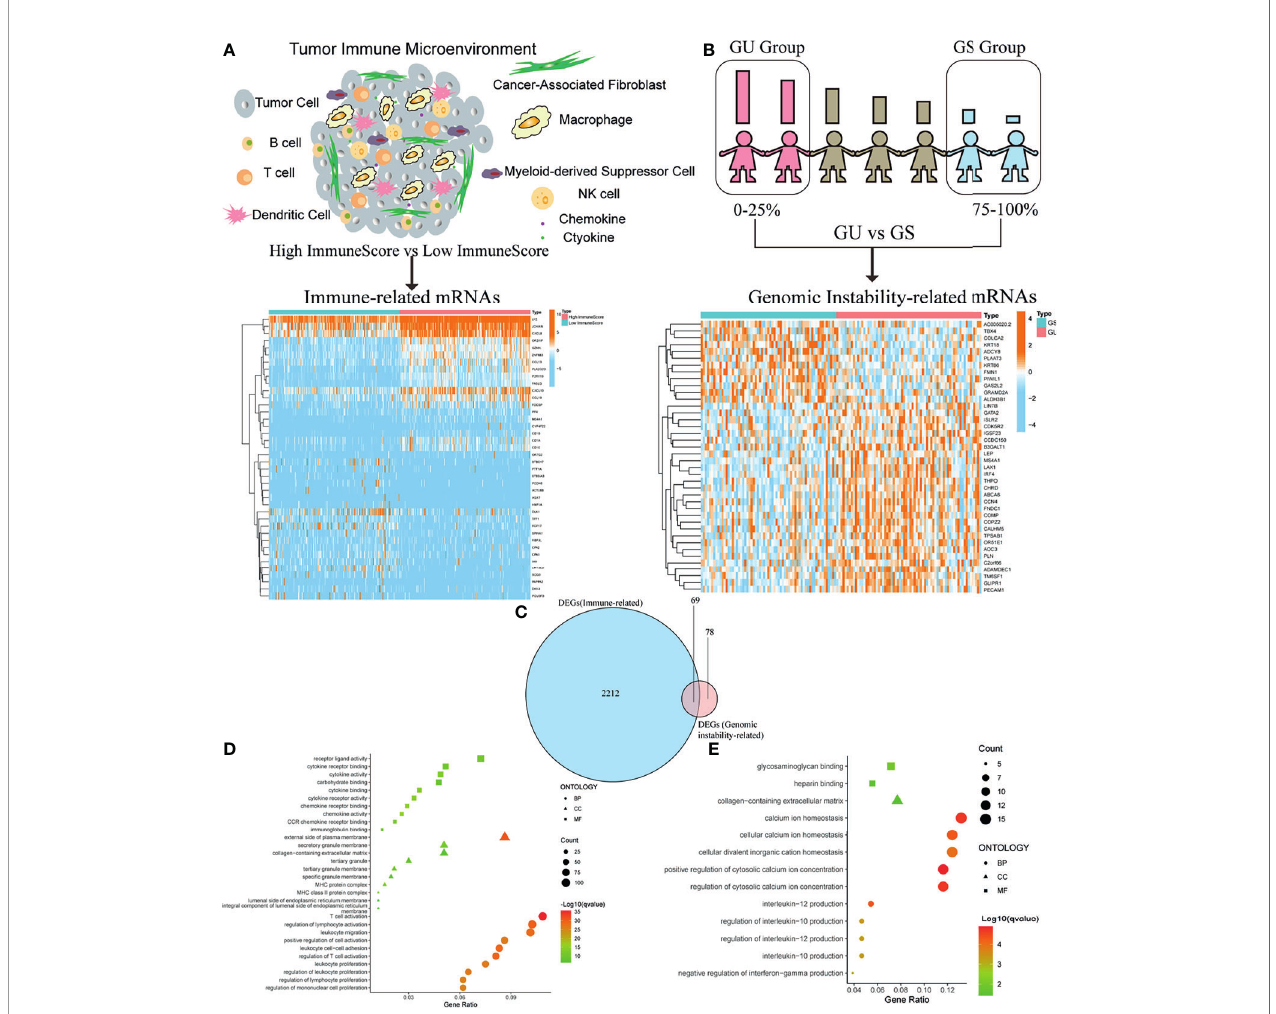
FIGURE 2 | Identi fi cation of differentially expressed genes (DEGs) both correlated with tumor immune microenvironment (TIME) and genomic instability of ovarian cancer (OC). (A) Heatmap for immune-related DEGs generated by comparison of the high score group vs. the low score group in ImmuneScore. The row name of heatmap is the gene name, and the column name is the ID of samples that are not shown in the plot. Differentially expressed genes were determined by Wilcoxon rank sum test with q < 0.05 and fold-change > 0.58 after log2transformation as the signi fi cance threshold. (B) Heatmap for genomic instability-related DEGs by comparison of the genomic unstable (GU) group vs. the genomic stable (GS) group, similar to (A) . (C) Venn plot showing common DEGs shared by immune-related DEGs and genomic instability-related DEGs, and q < 0.05 and fold-change > 0.58 after log2transformation as the DEGs signi fi cance fi ltering threshold. (D) GO enrichment analysis for 2,281 immune-related DEGs; terms with p and q < 0.05 were believed to be enriched signi fi cantly. (E) GO enrichment analysis for 147 genomic instability-related DEGs; terms with p and q < 0.05 were believed to be enriched signi fi